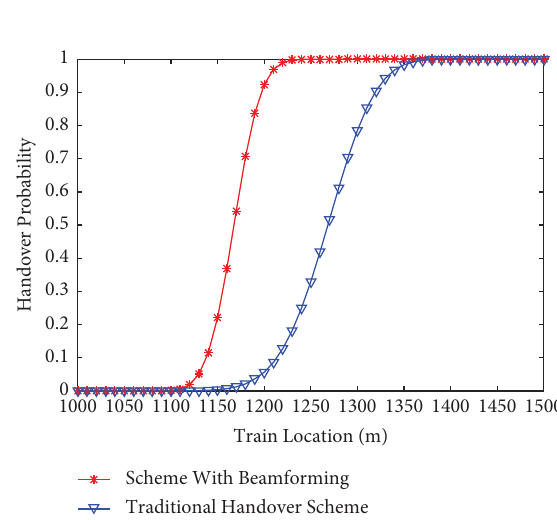
Figure 5: Received signal quality.